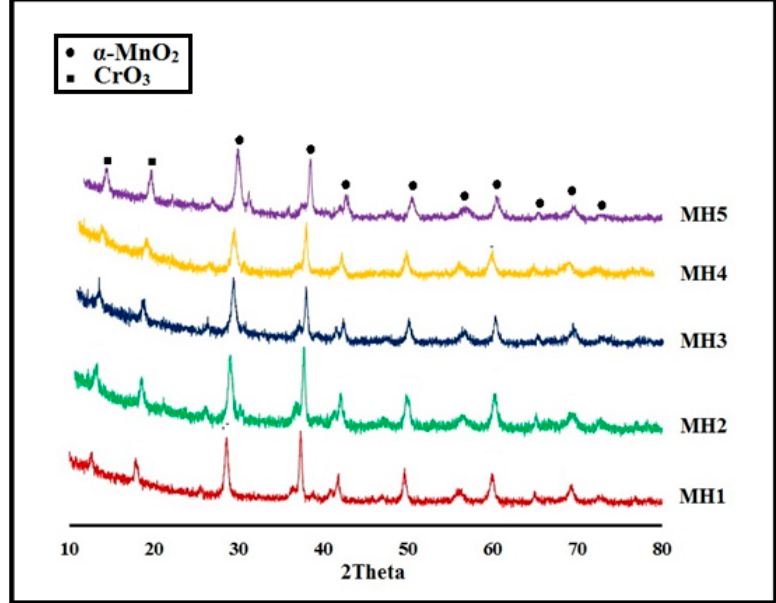
Figure 1. PXRD pattern of nanomaterials (MH1–MH5). (Powder patterns are matched with standard patterns—i.e., α -MnO 2 ((JCPD No.44-0141), (JCPD No. 01-1127), CrO 3 (JCPD No. 74-0326, 70-3766)).